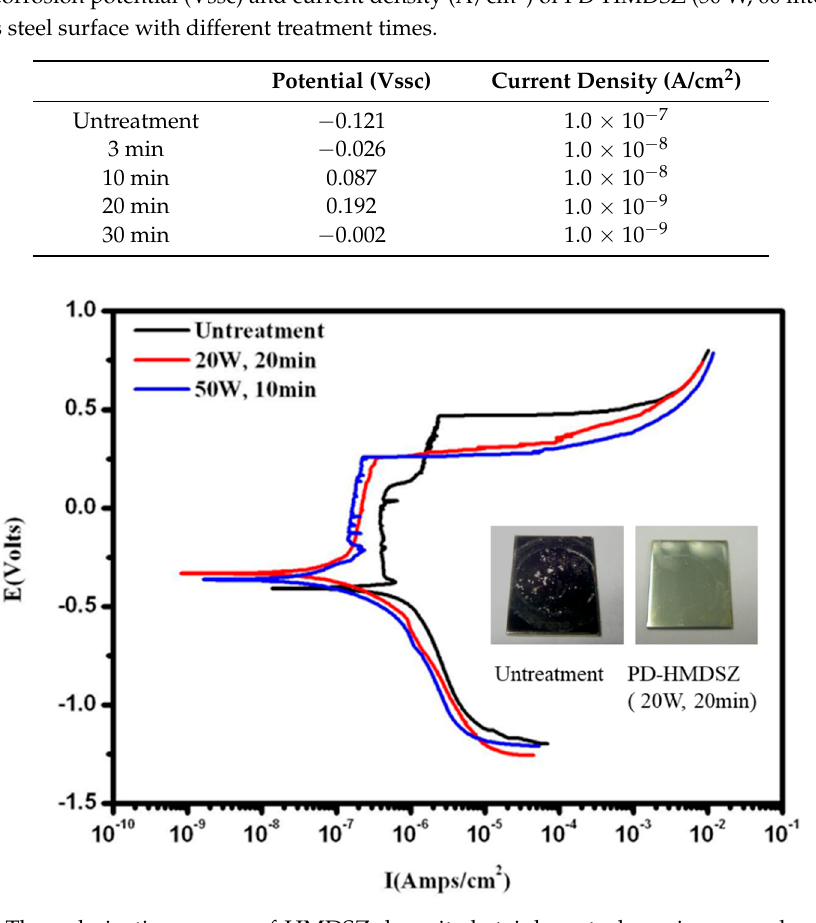
Figure 7. The polarization curves of HMDSZ-deposited stainless steel specimens under different plasma treatment plasma treatment conditions.